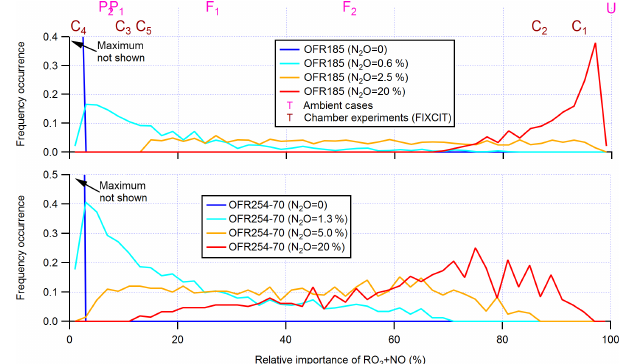
Figure 2. Frequency distributions of the relative importance of RO 2 + NO in the fate of RO 2 (with medium self- and cross-reaction rate constant and without RO 2 + OH and RO 2 isomerization consid- ered) for OFR185 (including OFR185-iN 2 O) and OFR254-70 (in- cluding OFR254-70-iN 2 O). Distributions for several different N 2 O levels are shown. Only good and risky conditions (in terms of non- tropospheric organic photolysis) are included in the distributions. Also shown is the relative importance of RO 2 + NO for several typ- ical ambient and chamber cases (see Table 2 for details on these